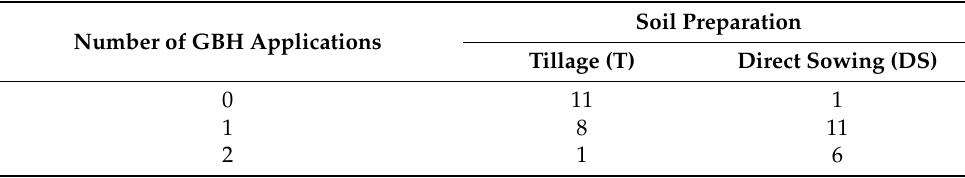
Table 1. Weeding and soil preparation practices at the sites of the study. The number of applications could not be determined at seven